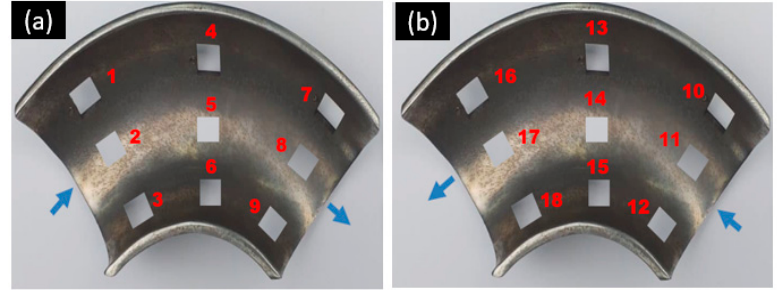
Figure 2. ( a , b ) Specimen location after test.